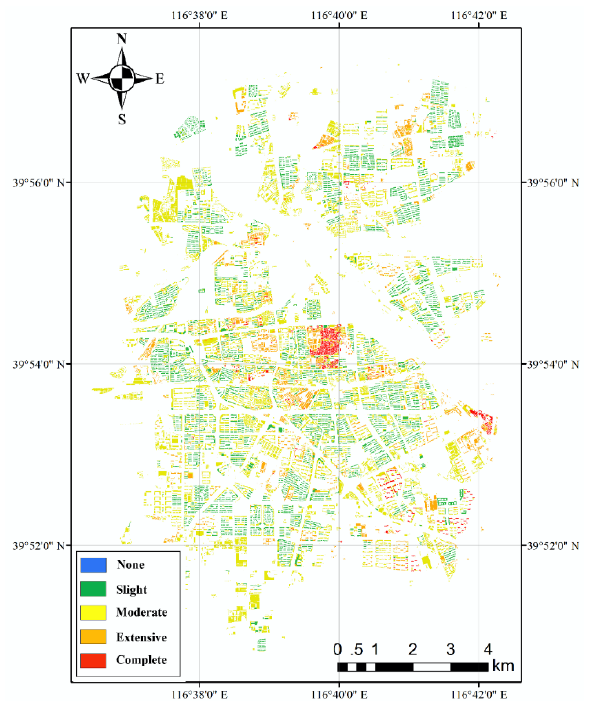
Figure 30. Distribution of seismic damage in Tongzhou downtown.